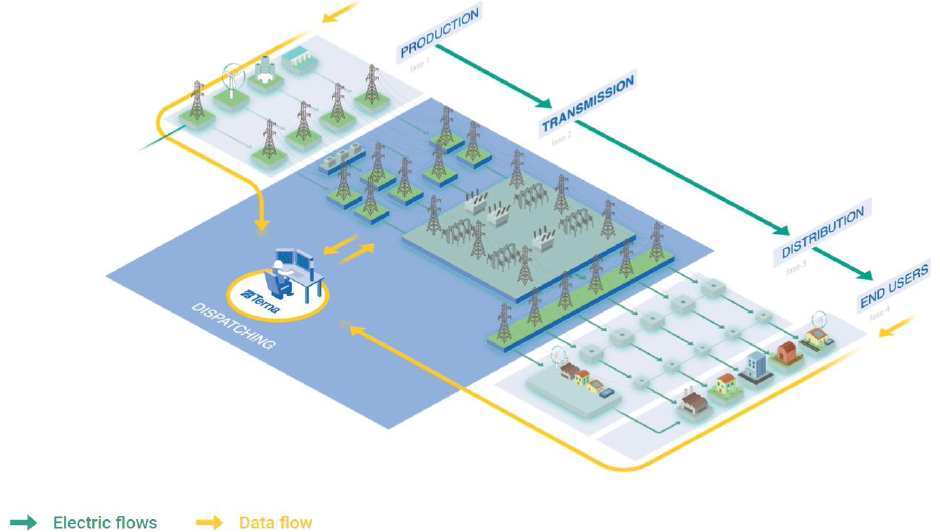
Figure 2. Graphical representation of the Italian energy supply chain [ Error! Reference source not found. ].